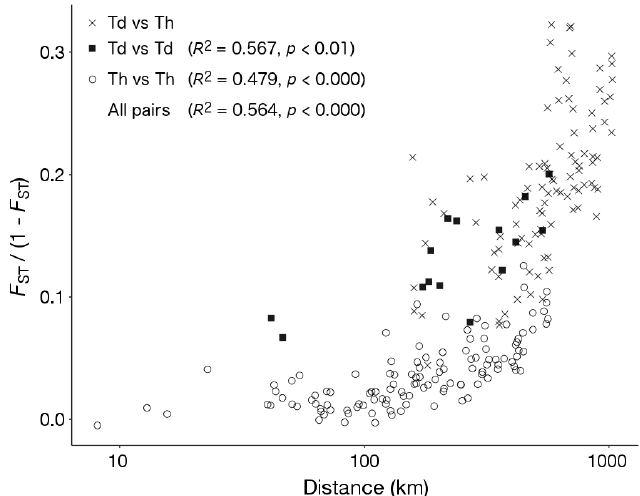
Figure A2. Relationships between pairwise genetic distances, F ST / (1 − F ST ), and the geographic distance separating 22 Thujopsis populations.